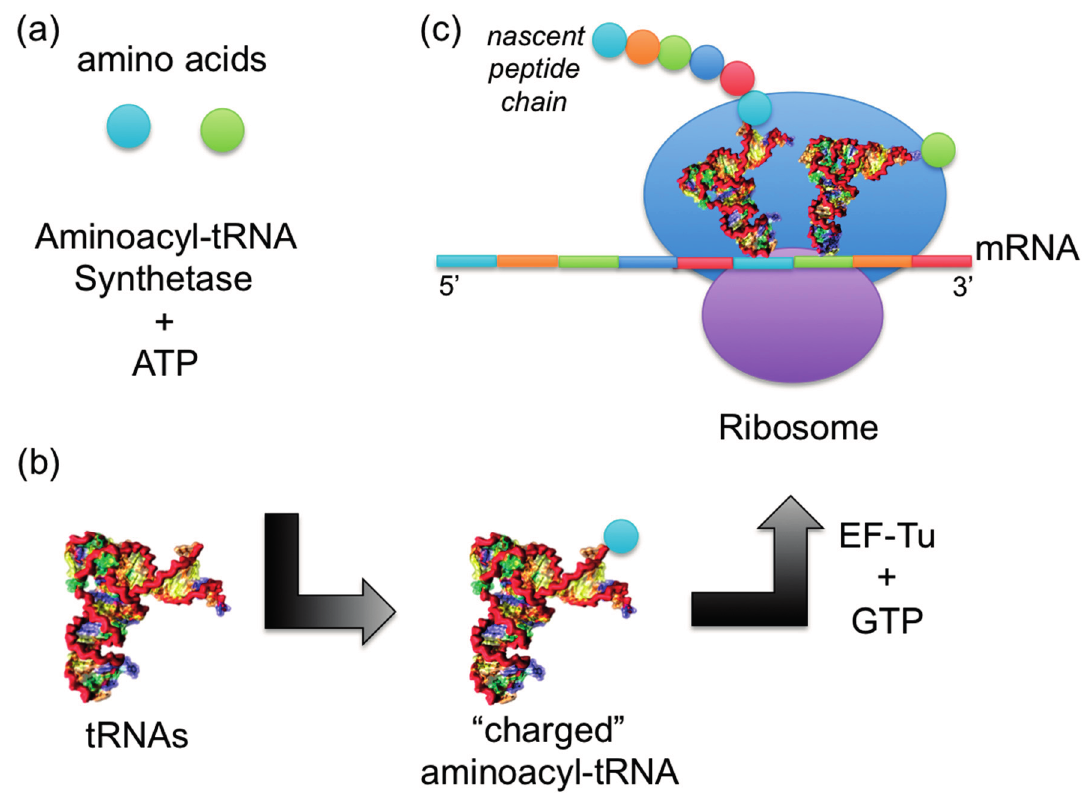
Figure 1. Overview of the role of tRNA in protein synthesis ( a ) Aminoacyl-tRNA synthetases catalyze the attachment of amino acids to their cognate tRNAs to result in “charged” aminoacyl-tRNAs; ( b ) Each tRNA has a specific sequence that corresponds to an amino acid. Multiple isoaccepting tRNAs may specify a single amino acid; ( c ) Nascent peptides are synthesized at the ribosome using the mRNA template. Charged tRNAs with their corresponding amino acids are delivered to the ribosome, one by one, by matching anticodons to mRNA codons to result in a